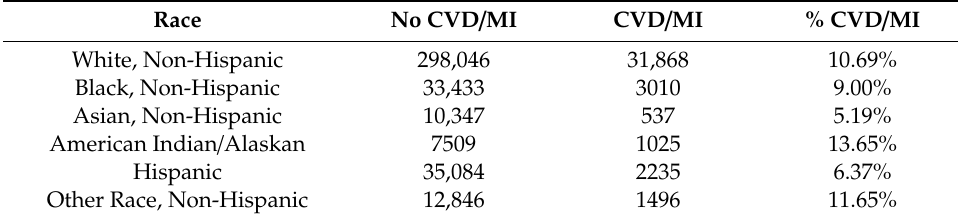
Other Race, Non-Hispanic Table 9. CVD / MI by state and territory, where green coloring indicates lower than the total percent. State White Black Asian